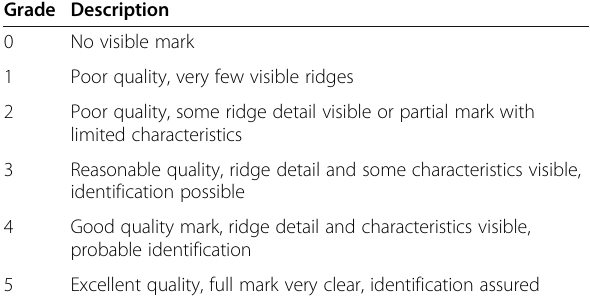
Table 1 The fingermark quality scale used in the assessment of developed